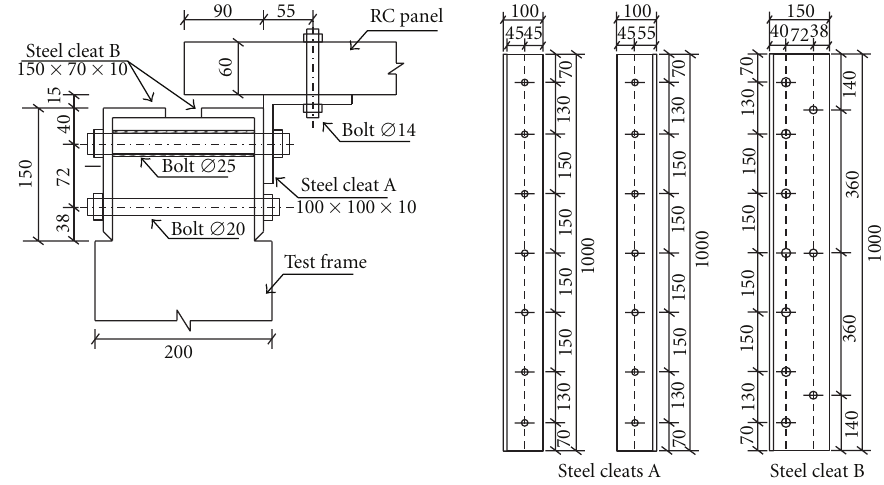
Figure 1: Details of connections between the panel and the test frame.